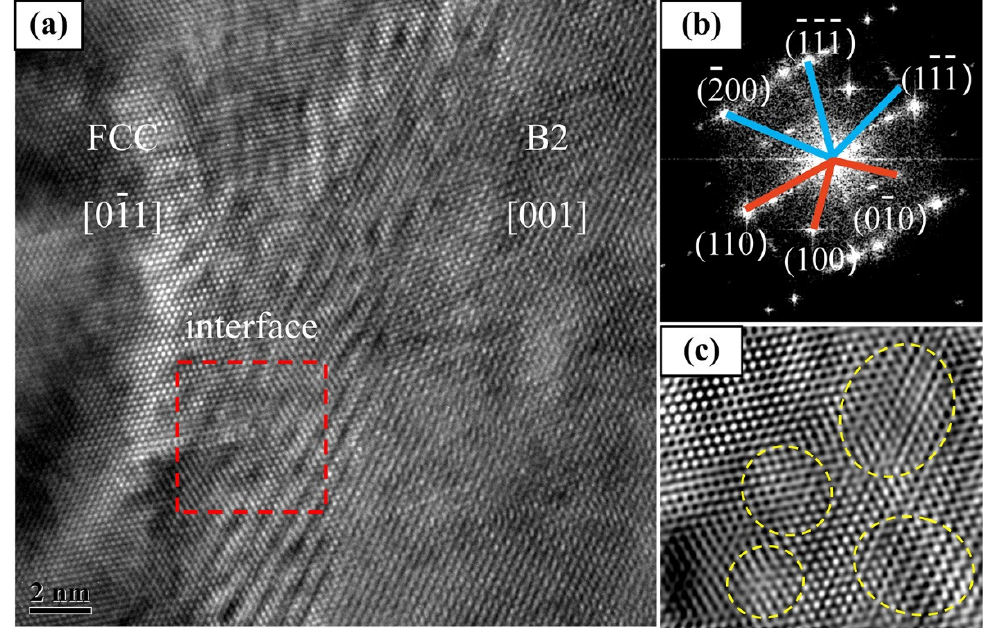
Figure 12. TEM image of Al 0.5 FeCoCrNi HEA manufactured by LMD: ( a ) high-resolution image of the dual-phase interface; ( b ) SAED pattern of dual phase in the high-resolution image; ( c ) local high-resolution image at the dual-phase interface.